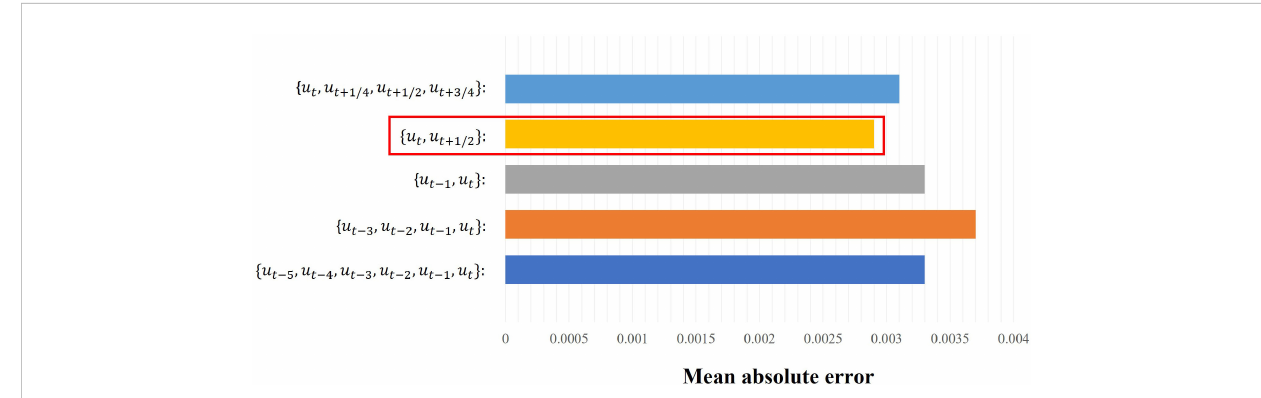
FIGURE 7 Mean absolute error comparison of the prediction results of models using different sets of time steps as the time series information input to TSI-SD. For the y-axis, the different colors represent different input sets of time steps. The legend represents mean absolute error and the red box shows the best result ( f u t , u t + 1 g 2